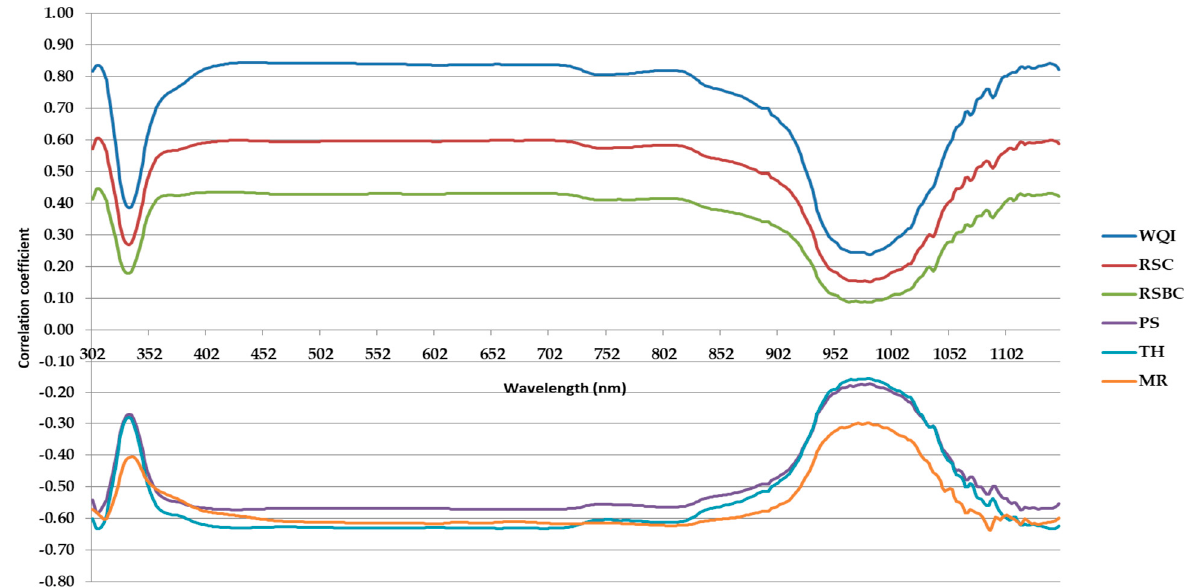
Figure 7. Correlation coefficient between the original canopy spectral reflectance of the full wavelengths range (302–1148 nm) and different irrigation water quality indices (IWQIs) including water quality index (WQI), residual sodium bicarbonate (RSBC), total hardness (TH), potential salinity (PS), residual sodium carbonate (RSC), and magnesium hazard (MH).